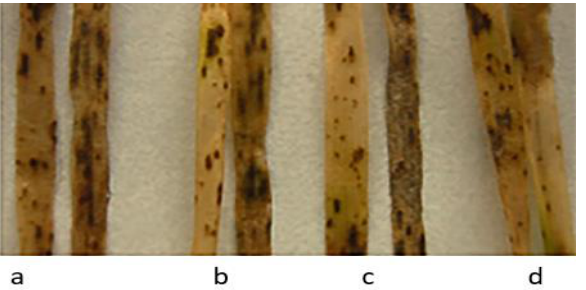
Figure 4. HLB development on seedlings of wild wheat species samples from the VIR collection after infection with a mixture of B. sorokiniana isolates: ( a ) T. urartu k-58504; ( b ) T. araraticum k-28244; ( c ) T. boeoticum k-62492; and ( d ) T. dicoccoides k-62364.